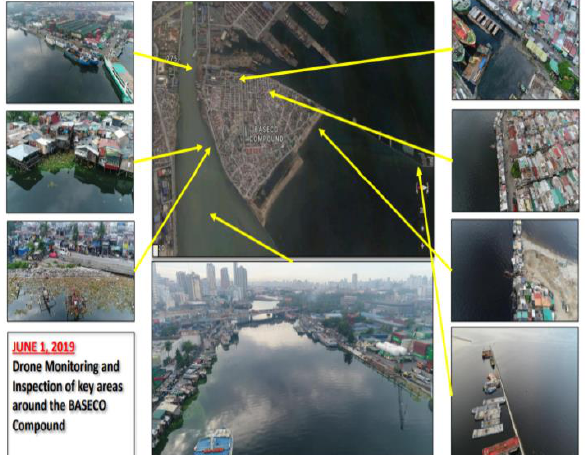
Figure 12 . Drone Monitoring of Key Areas in BASECO area by